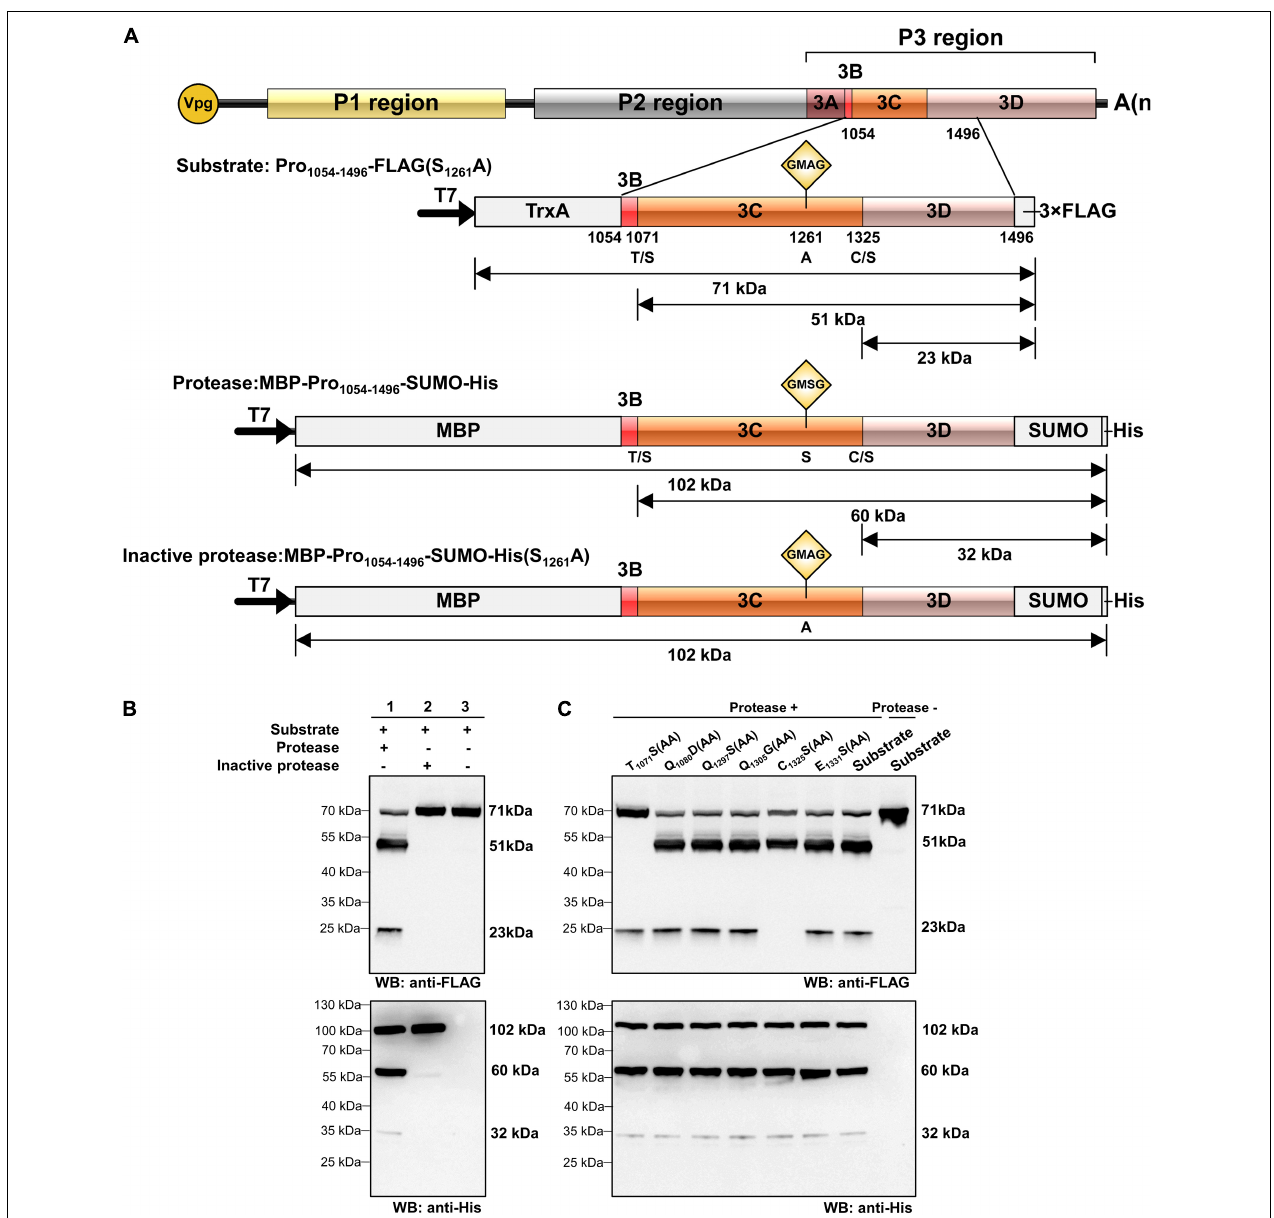
FIGURE 3 | Analysis of rice curl dwarf-associated picornavirus (RCDaV) 3Cpro trans -cleavage activity. (A) Schematic diagrams of RCDaV genome, the 3 × FLAG tagged mutant Pro 1054 − 1496 -FLAG(S 1261 A), the MBP, SUMO and 6 × His tagged MBP-Pro 1054 − 1496 -SUMO-His and its mutant MBP-Pro 1054 − 1496 -SUMO-His (S 1261 A). The MBP-Pro 1054 − 1496 -SUMO-His was used as an active 3Cpro. The Pro 1054 − 1496 -FLAG(S 1261 A) and the MBP-Pro 1054 − 1496 -SUMO-His(S 1261 A) were used as the substrates and an inactive 3Cpro, respectively. (B,C) In vitro trans -cleavage activities of the MBP-Pro 1054 − 1496 -SUMO-His and its